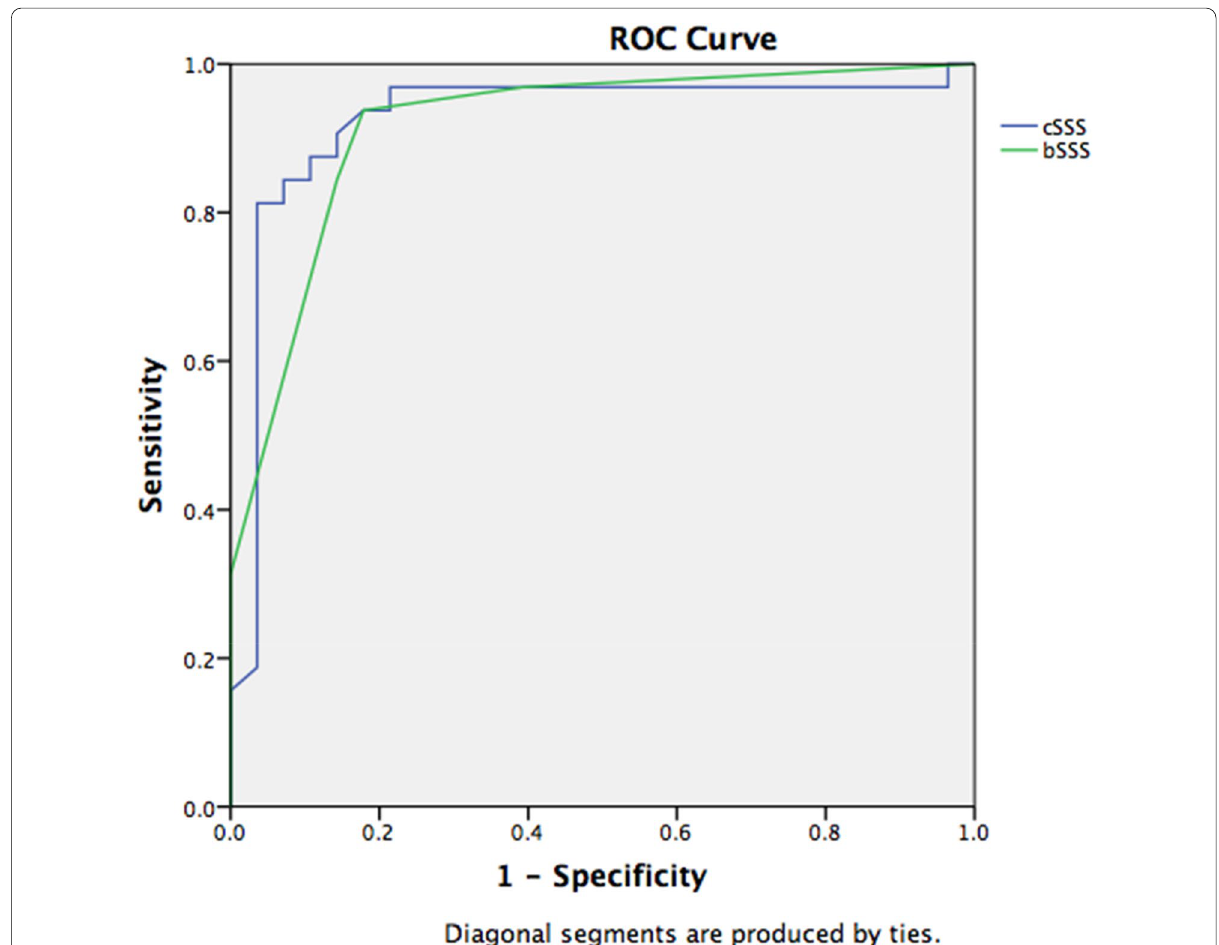
Fig. 2 Receiver operating curve (ROC) and area under the ROC for mortality of bedside Septic Shock Score (bSSS) calculated in the first 24 h of admission for septic